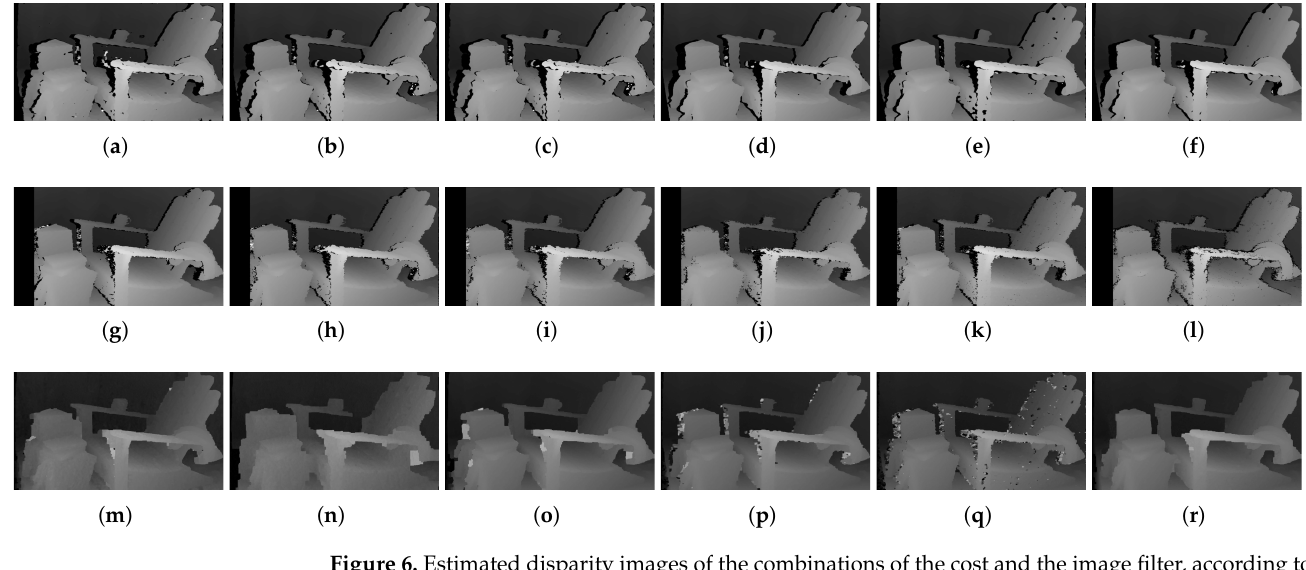
Figure 6. Estimated disparity images of the combinations of the cost and the image filter, according to each stereo matching method over the synthetic active dataset. All attributes of the active IR images were set to default values. In SGM, the columns equal to the max disparity value are not used in the left image because the corresponding pixels in the right image cannot be used for comparison. Therefore, missing pixels appear at the left edge of the image [33]. ( a ) Window, SAD. ( b ) Window, Mean/SAD. ( c ) Window, LoG/SAD. ( d ) Window, BilSub/SAD. ( e ) Window, Rank/SAD. ( f ) Window, Census. ( g ) SGM, AD. ( h ) SGM, Mean/AD. ( i ) SGM, LoG/AD. ( j ) SGM, BilSub/AD. ( k ) SGM, Rank/AD. ( l ) SGM, Census. ( m ) GC, AD. ( n ) GC, Mean/AD. ( o ) GC, LoG/AD. ( p ) GC, BilSub/AD. ( q ) GC, Rank/AD. ( r ) GC,